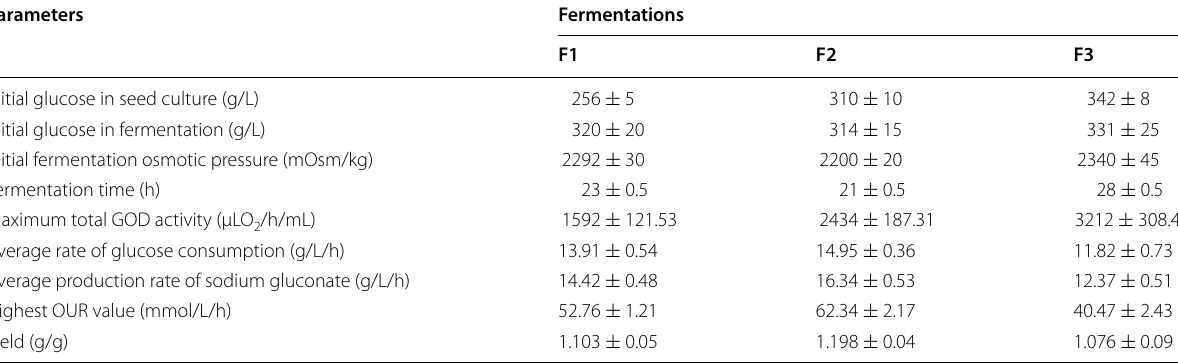
Table 2 Calculated parameters of sodium gluconate fermentation by A. niger inoculated with seed culture for three dif- ferent initial glucose concentrations